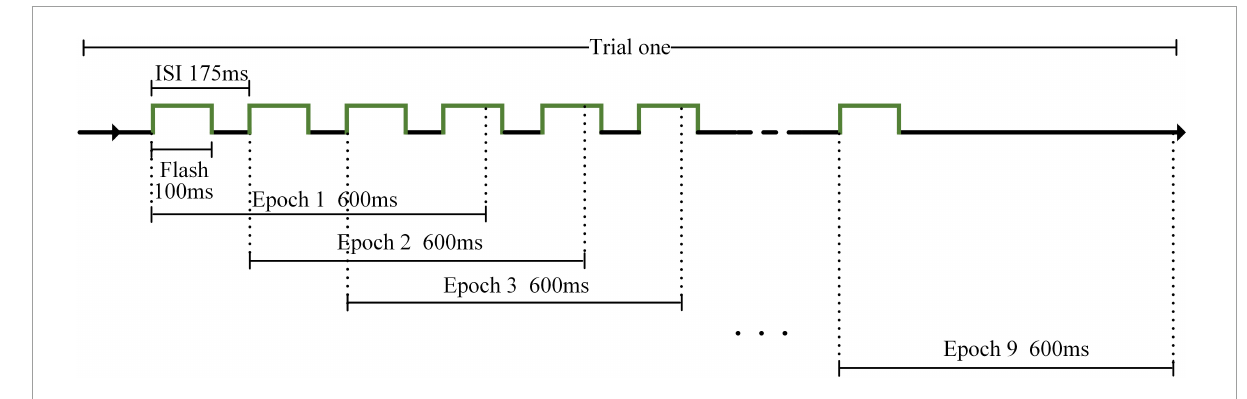
FIGURE5 Electroencephalogram (EEG) division of